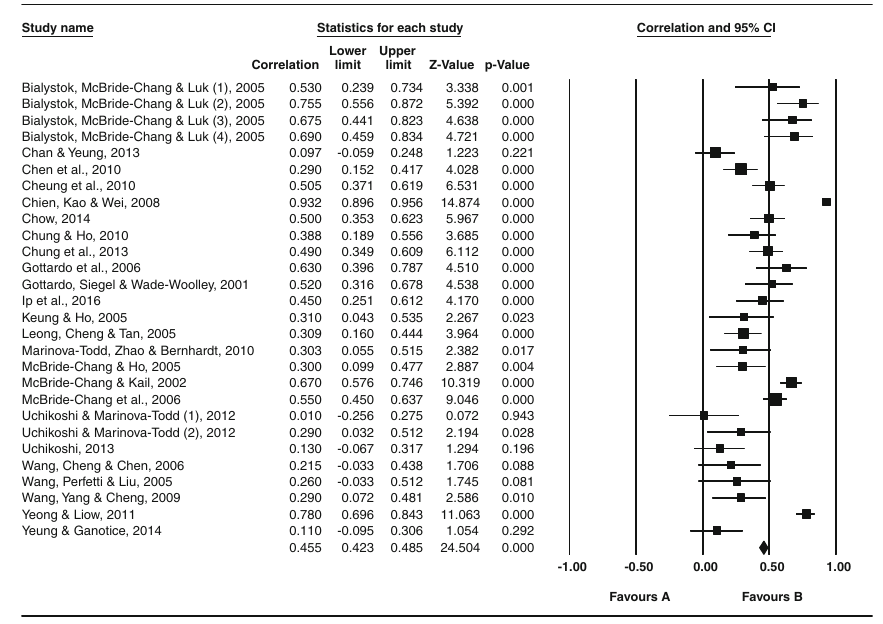
Fig. 2 Overall average correlation and correlation with confidence interval for each study correlating Chinese and English phonological awareness. Note. Overall correlation shows at the bottom of the figure. Diamond shape = overall correlation average across listed studies on graph. Size of square reflects sample size, with bigger square representing a larger sample size (Bialystok, McBride-Chang & Luk 2005; Chen et al., 2010;